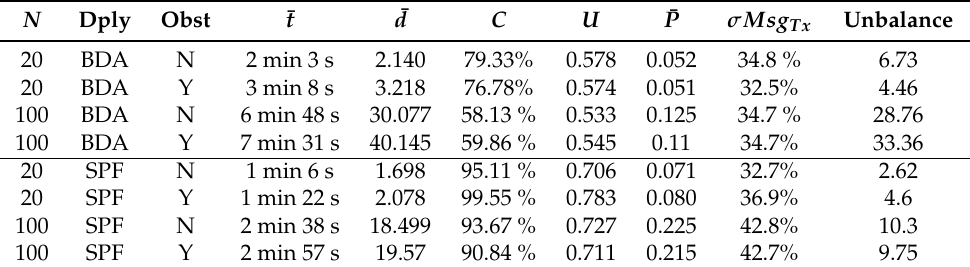
Table 1. Deployment of different mesh networks using BDA and SPF.